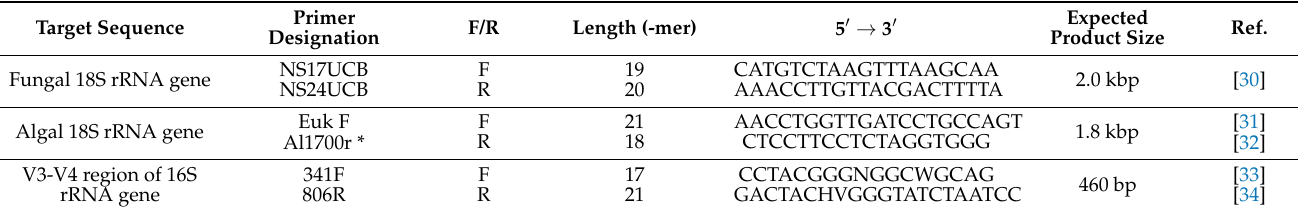
Table 2. List of forward (F) and reverse (R) primers for PCR amplification of the target sequences. Target